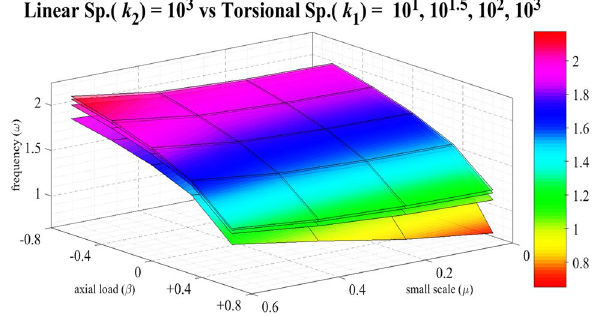
Fig. 6 Fundamental frequency plotted against the axial load ( 𝛽 2 ) and the small-scale parameter ( 𝜇 ) for different values of 𝜅 1 and 𝜅 2 , with the tip mass ratio 𝜂 = 0